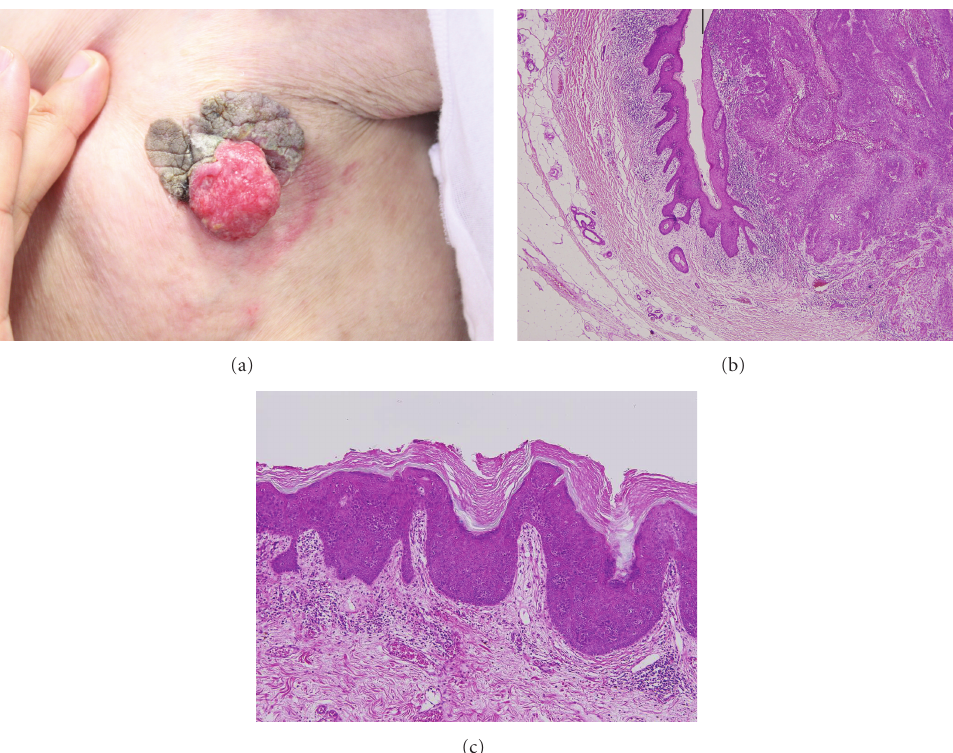
Figure 1: (a) A red tumor on the left axilla developed in a congenital verrucous plaque. (b) SCC lesion (left side of the vertical bar) developed within the epidermal nevus (hematoxyline-eosin stain, original magnification: × 40). (c) Verrucous proliferation of the keratocyte and partial granular degeneration which were compatible with a finding of an epidermal nevus (hematoxyline-eosin stain, ×